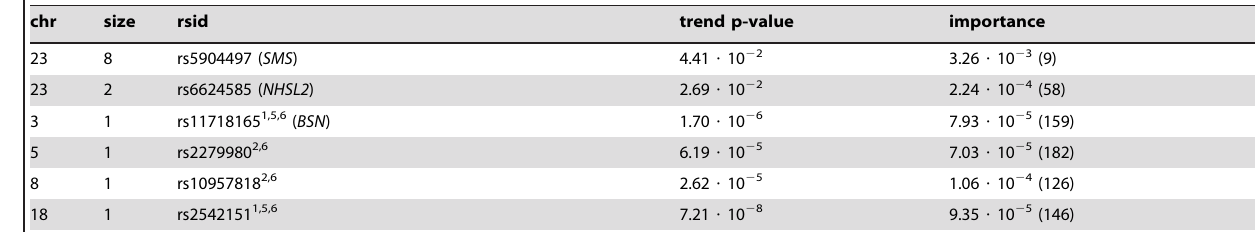
Regions highlighted from the top 200 SNPs according to SNP importances with RF (top) and T-Trees (bottom) on CD qc . Each row corresponds to a set of SNPs obtained by merging contiguous SNPs in the rankings that are not separated by more than 20 SNPs. For readability, only groups of more than 2 SNPs appear in the tables. Markers that are isolated but reported as associated in [25] are nevertheless compiled at the bottom of both tables (6) . For each region, the columns provide the chromosome number, the number of important SNPs in the region, the most important SNP in the region (and its gene name if provided by PheGenI [40]), the p -value of this SNP and its importance. (1) and (2) : the regions reported as strongly (with a trend or a genotypic p -value , 10 2 5 ) and moderately (with a trend or a genotypic p - value between 10 2 5 and 10 2 4 ) associated in [25]. (5) : also reported by [37]. (4) : regions identified by both RF and T-Trees. (3) : the two novel regions mainly spotted by T- Trees.